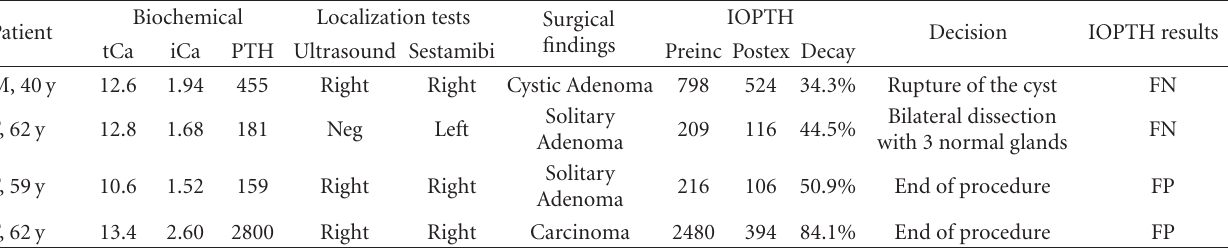
Table 4: False results of IOPTH.